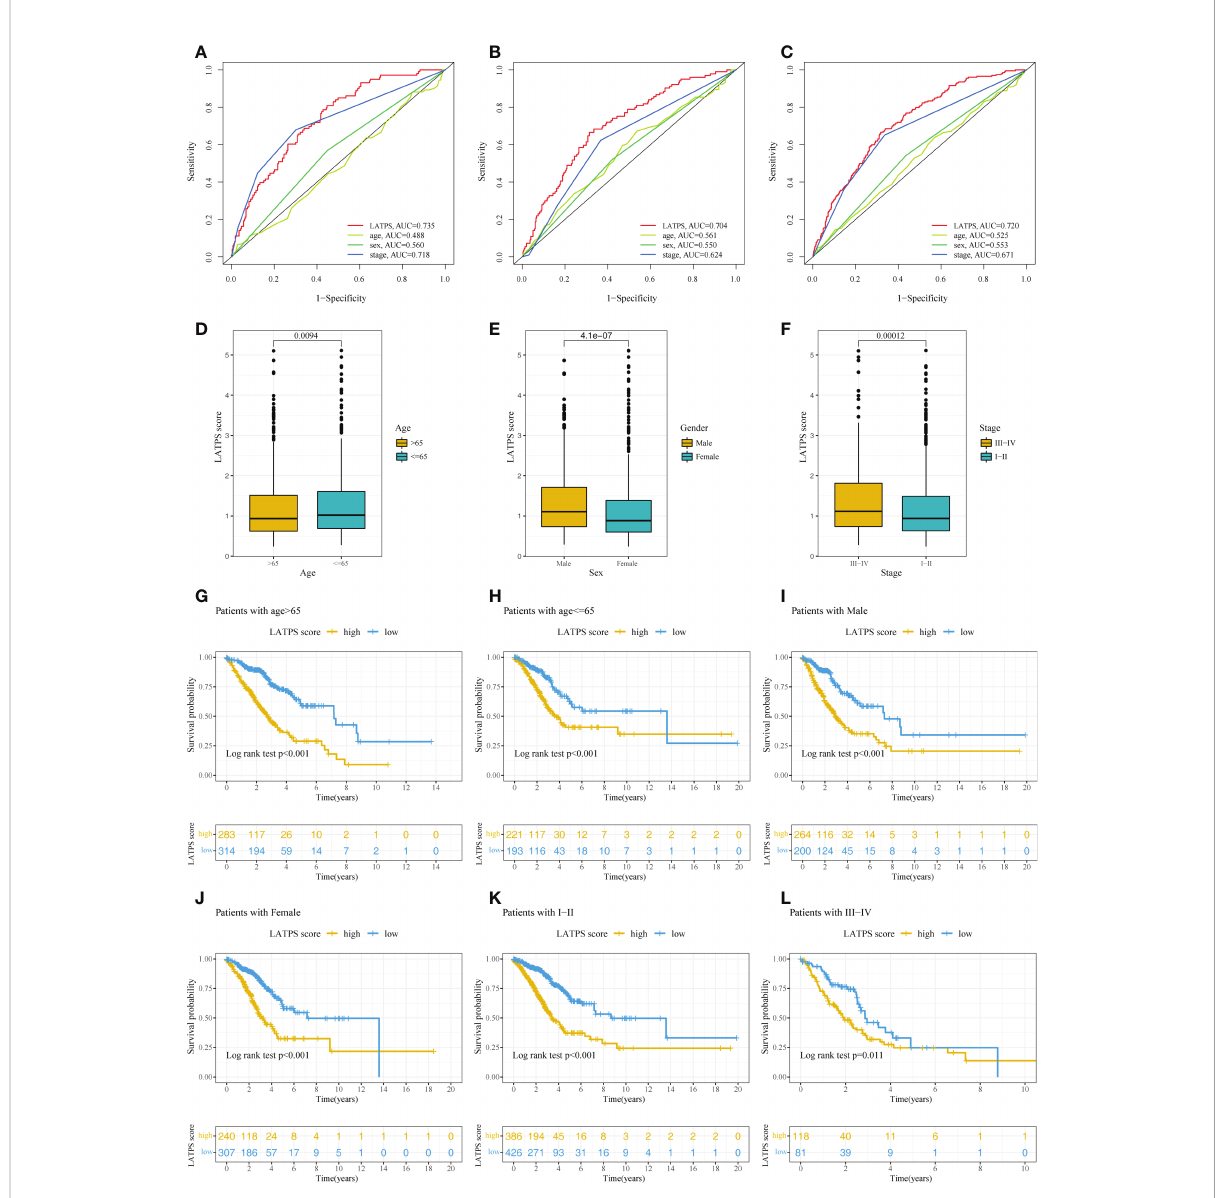
FIGURE 7 Con fi rmation of the LATPS via strati fi cation of patients based on speci fi c demographic and clinical features. Time-dependent ROC curve analysis of the LATPS score and clinicopathological factors to assess the predictive capacity of the LATPS in the (A) training, (B) test, and (C) total cohorts. (D-F) Boxplot showing the relationships between the LATPS score and clinicopathologic factors for all patients with LUAD. (G-L) Kaplan – Meier curve analysis for patients of (G) age > 65, (H) age ≤ 65, (I) Male, (J) Female, (K) Stage I – II, (L) Stage III – IV in the LATPS-high and LATPS-low subgroups. LATPS, LUAD tumor microenvironment prognostic signature; LUAD, lung adenocarcinoma; ROC, receiver operating